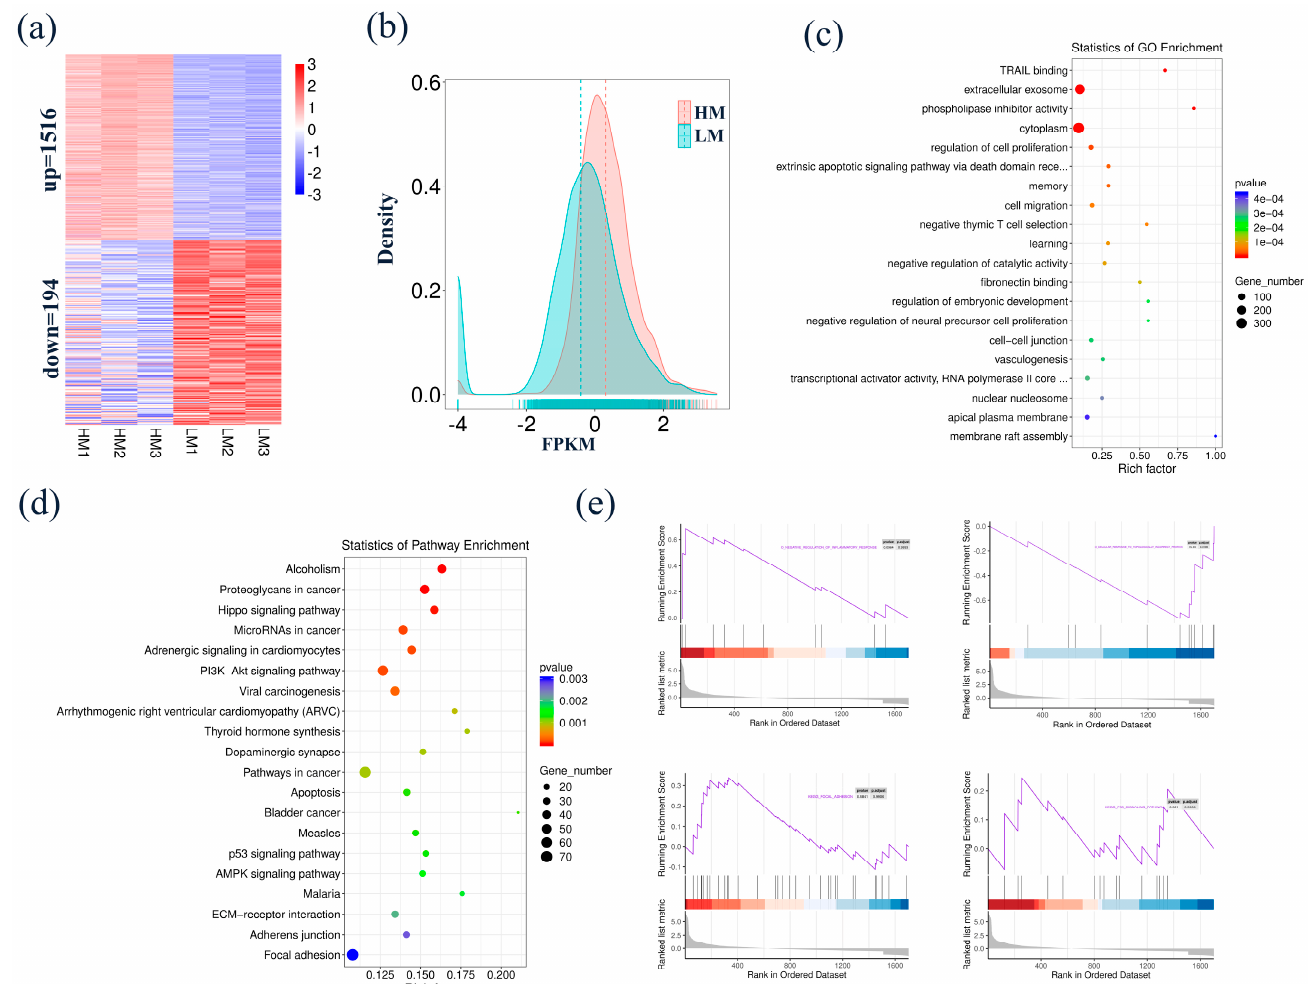
Figure 4. Identification and functional analysis of DEGs in blastocyst-stage embryo. ( a ) Comparing HM with LM, a total of 1710 DEGs were identified, including 1515 up-regulated and 194 down-regulated DEGs. ( b ) Density plot of FPKM between HM and LM. ( c , d ) The GO and KEGG enrichment analyses of the DEGs. ( e ) The DEGs were enriched in negative thymic T cell selection, p53 signaling pathway, and focal adhesion.